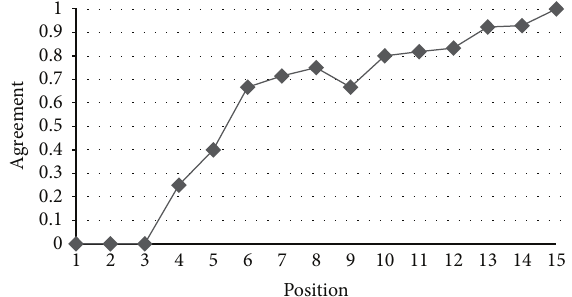
Figure 8: Agreement between the IPA and AHP rankings of functional